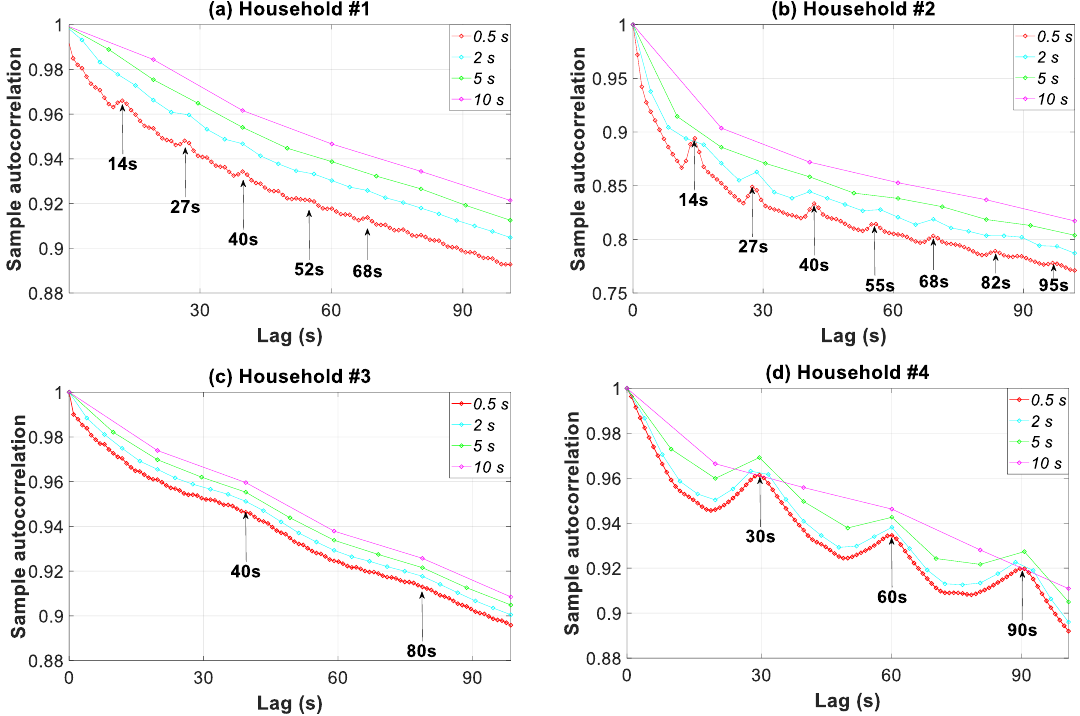
Figure 14. Autocorrelation function of the consumption load profile in households #1 to #4 for four data granularities.